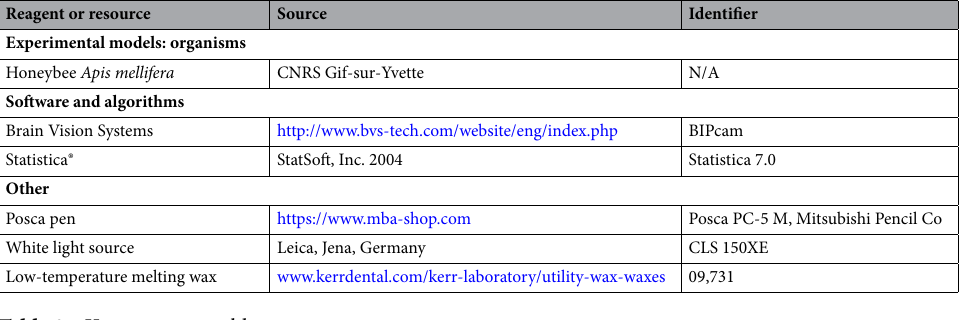
Table 2. Key resources